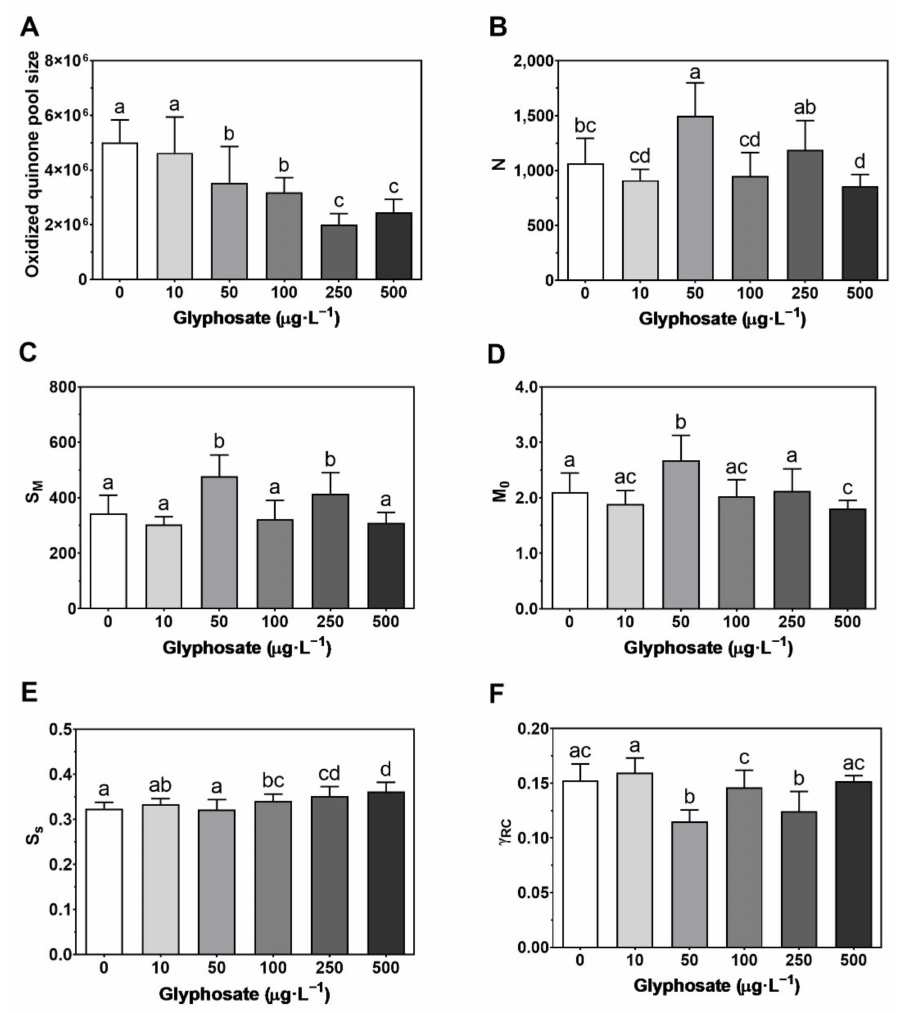
Figure 3. Photosystem II and ETC-related photochemical traits: ( A ) oxidized quinone pool; ( B ) reac- tion center turnover rate (N); ( C ) the energy needed to close all reaction centers (S M ); ( D ) the net rate of PS II RC closure (M 0 ); ( E ) smallest possible normalized total area when each QA is reduced only once (S S ); ( F ) the probability that a PSII chlorophyll molecule function as an RC ( γ RC ), in Ulva lactuca following a 48-h exposure to a glyphosate-based herbicide formulation in different concentrations (mean ± s.d., n = 18, different letters indicate significant differences between treatments at p < 0.05). In the rapid light curve (RLC)-derived parameters, no significant differences were observed in the photosynthetic efficiency ( α ), the relative maximum electron transport rate (rETR max ), or light saturation (E k ), although there was a decrease in photoinhibition ( β ) when subjected to 100 µ g · L − 1 (Supplementary Figure